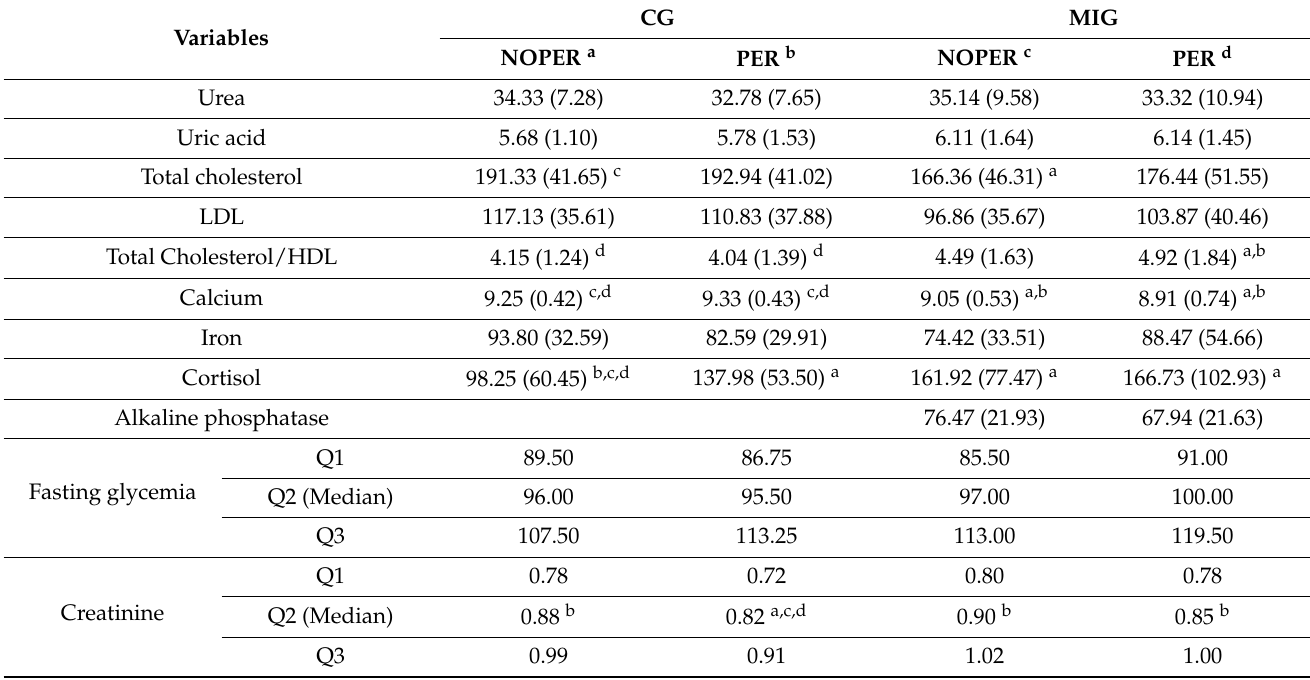
Table 3. Biochemical parameters of the four groups, means and standard deviation, medians, quartiles, ANOVA and Kruskal–Wallis